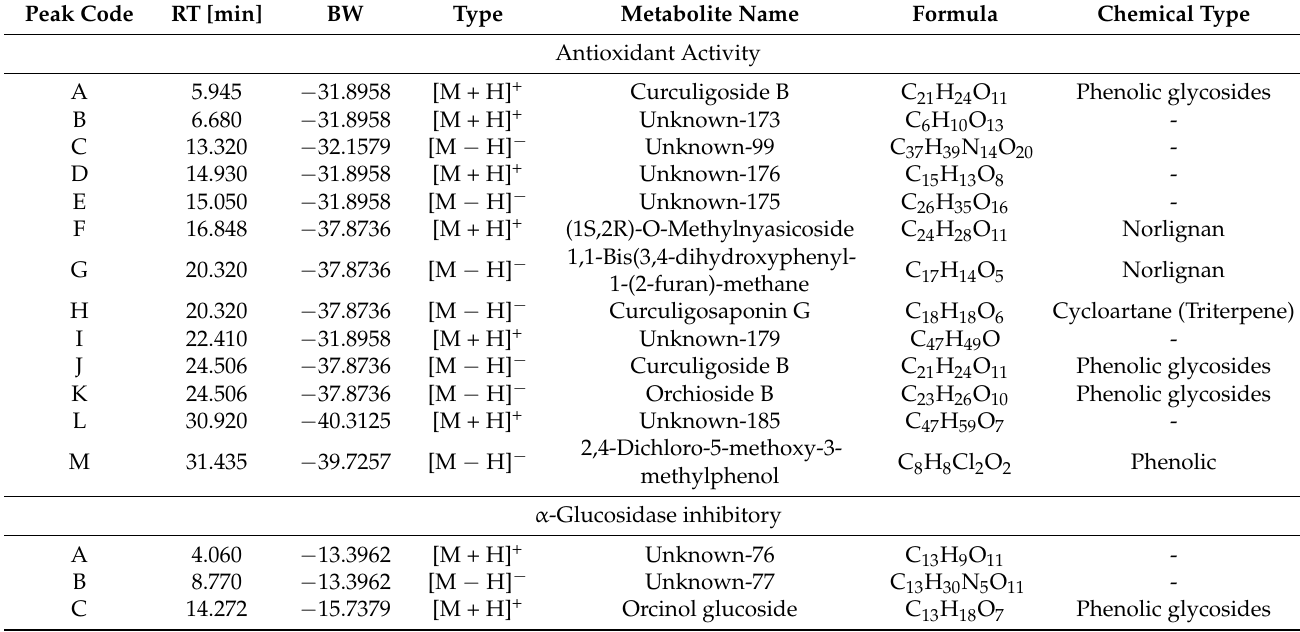
Figure 3. Partial least squares (PLS) plot weighted regression coefficients (important variables) of antioxidant ( A ) and α -glucosidase inhibitory ( B ) activities in 70% ethanol extract of C. orchioides and C. latifolia using UHPLC-Q-Orbitrap HRMS. Table 4. The compounds identified in the 70% ethanol extracts of C. orchioides and C. latifolia using UHPLC-Q-Orbitrap HRMS that contributed to the antioxidant and α -glucosidase inhibitory